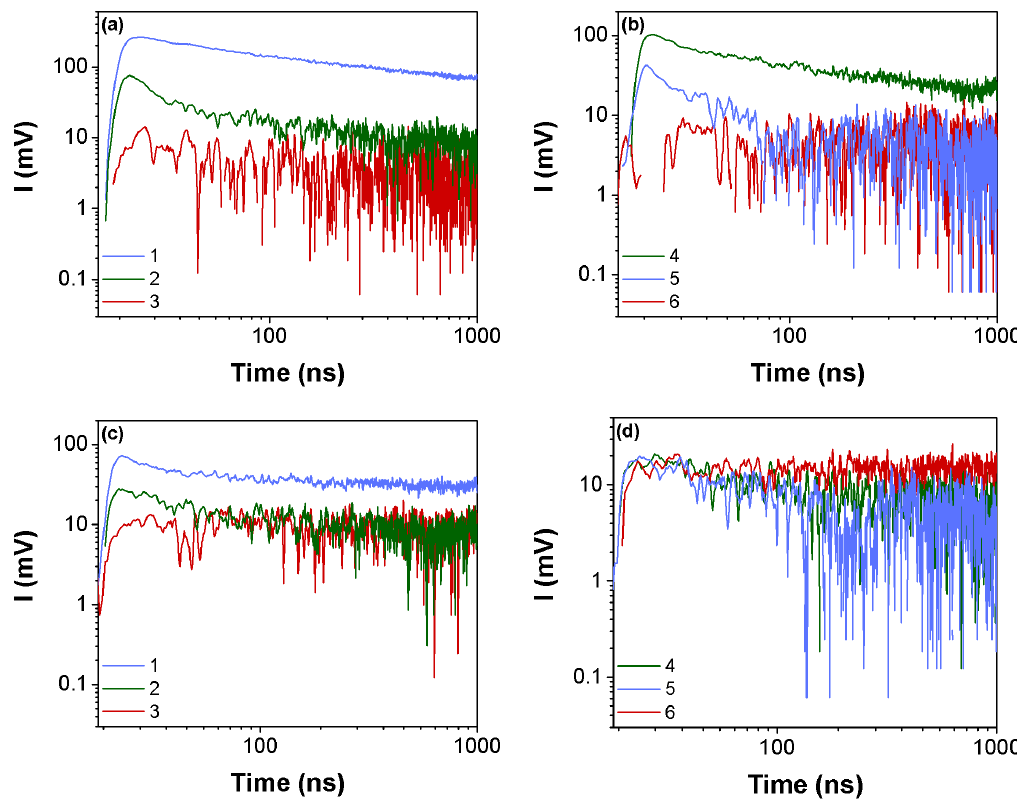
Figure 6. Time-resolved microwave conductivity (TRMC) transient signal of ( a,c ) P25 (1), syn-HKUST-1 (2), com-HKUST-1 (3) ( b,d ) TiO 2 /HKUST-1 composites: 50TiO 2 P25/com-HKUST-1 (4),